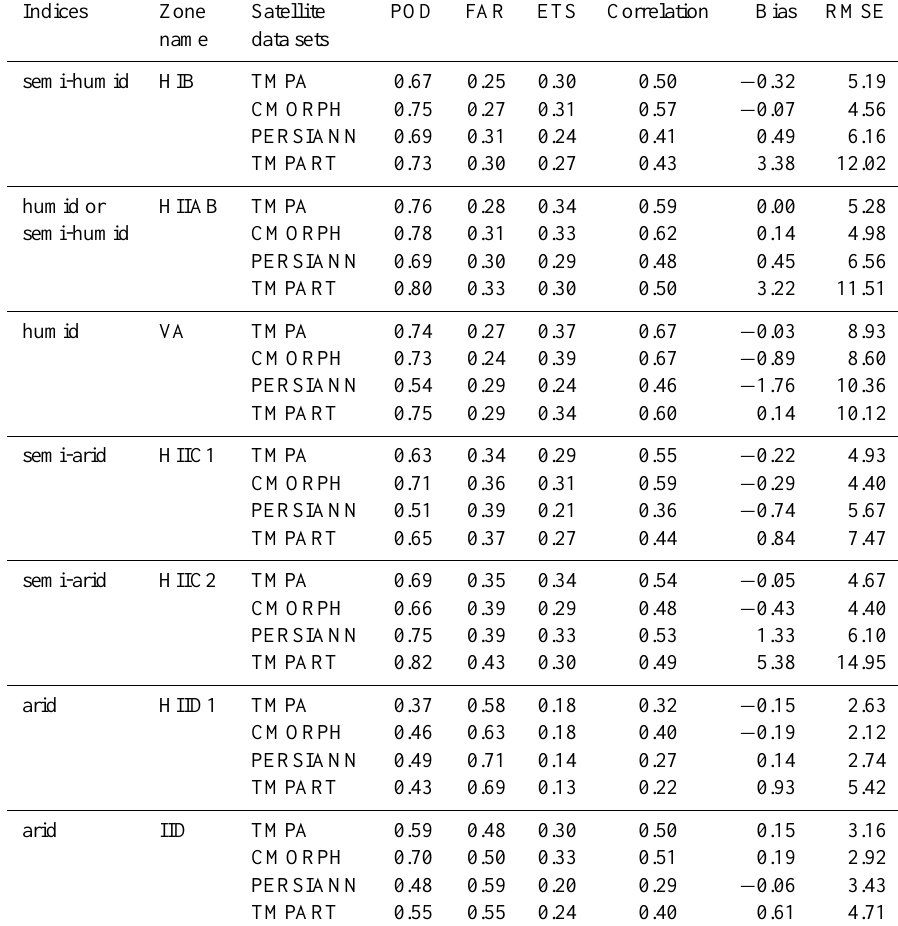
Table 4. Evaluation statistics (calculated at a daily timescale) of rain gauge measurements versus satellite estimates over different zones. Indices Zone Satellite POD FAR ETS Correlation Bias RMSE name data sets semi-humid